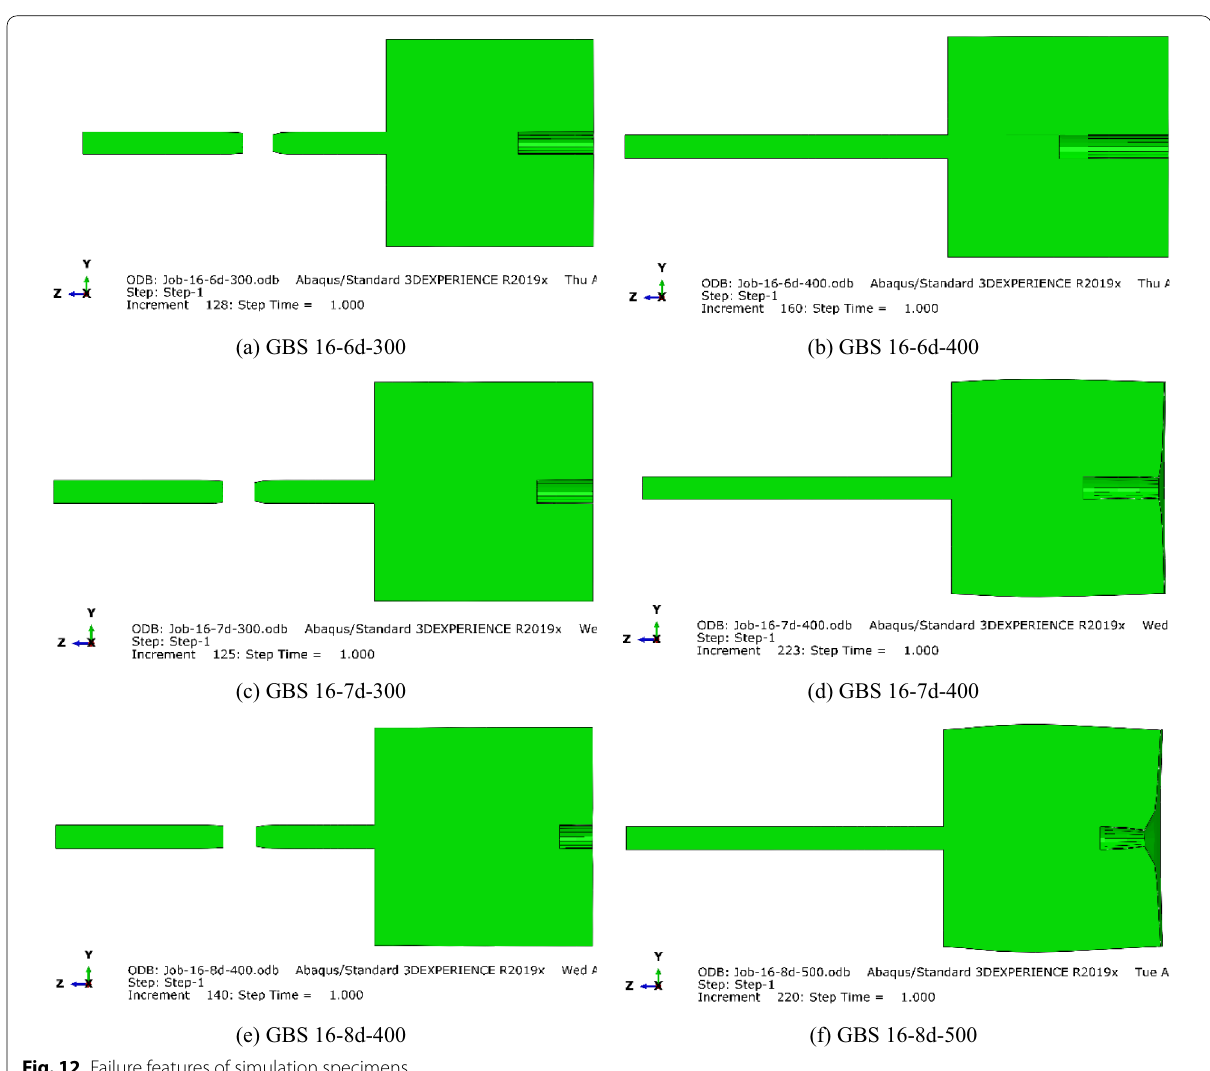
Fig. 12 Failure features of simulation